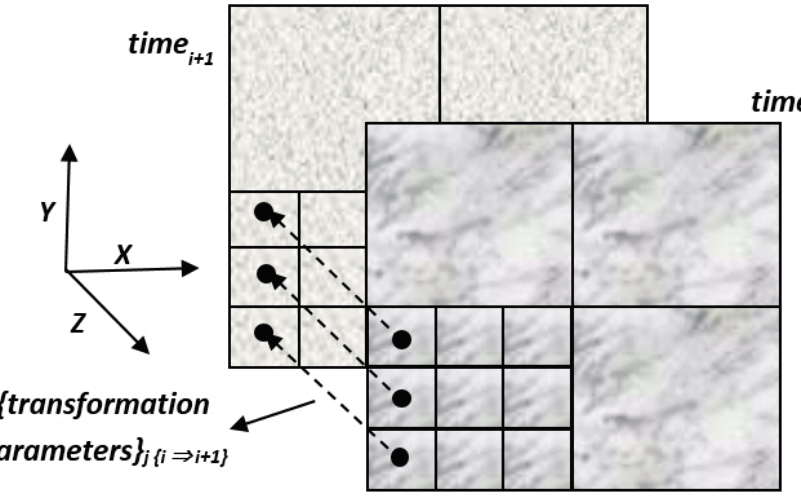
Figure 8. Topographic databases with times i and i + 1 (front and background). Each matrix-cell { j } in i stores a set of corresponding transformation parameter that best describe the relative spatial geometry of the mutual homologous topographic frames i + 1 that were matched in the Iterative Closest Point (ICP)